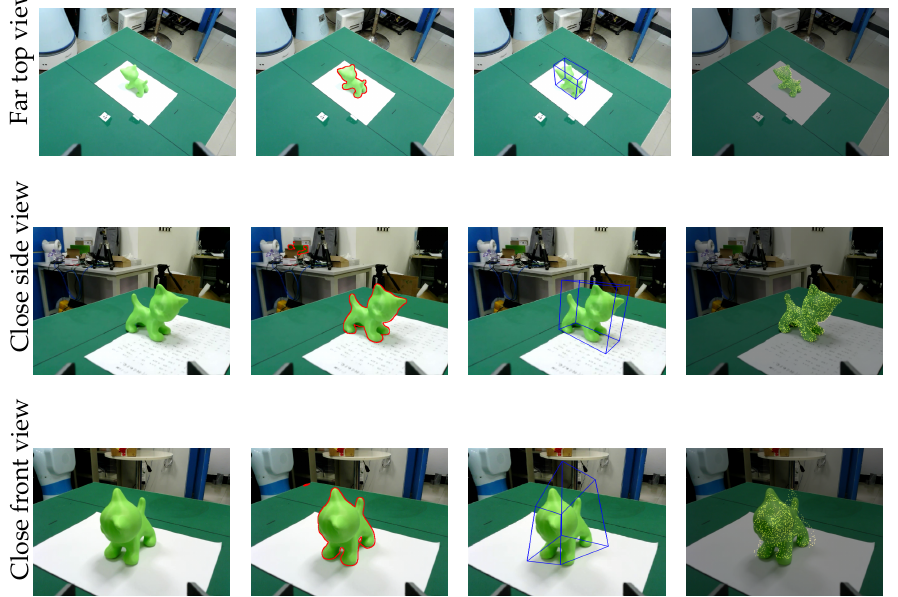
Figure 5. Estimating 6D pose using PV-net at different viewpoints. The target object in the original RGB image ( a ) is first segmented into “cat” labels, i.e., pixels enclosed by the red contours in ( b ), which are then processed by PV-net to generate a prediction of the object’s pose ( c ). The confidence of the predicted pose is checked against the reprojection of the object’s CAD model ( d ).